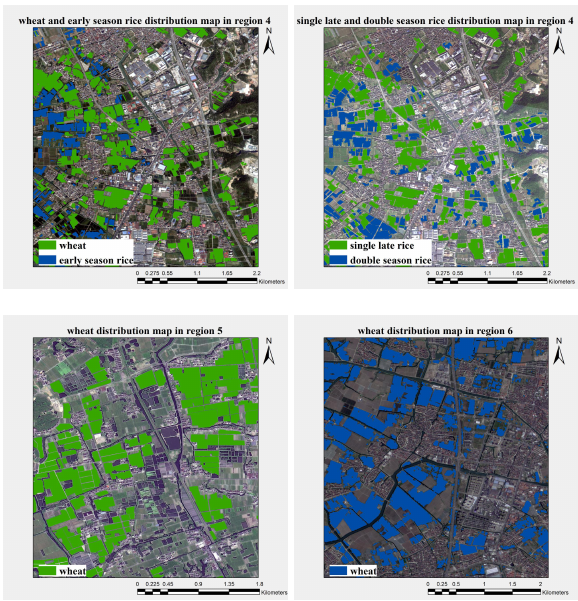
Figure 9. The Monitoring result of grains in different Regions